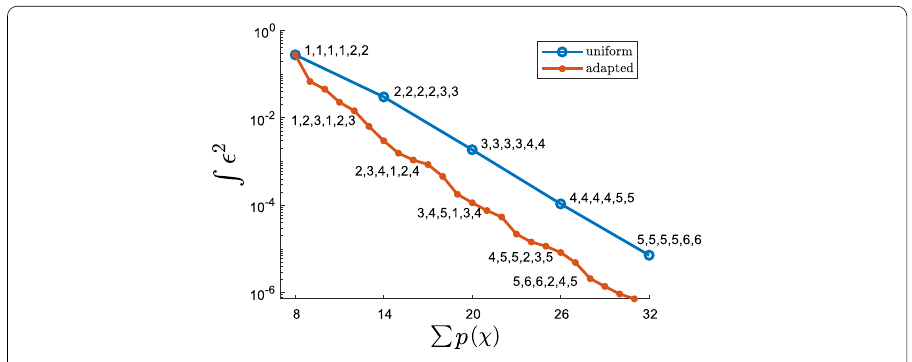
Fig. 8 Comparison between the uniform mesh refinement and the adaptivity method for the integral of the energy of the error as a function of the combination of polynomial degrees. The detail numbers are the the degrees of the approximation in each parameter, respectively k 1 , k 2 , β 1 , γ 1 , b 1 , b